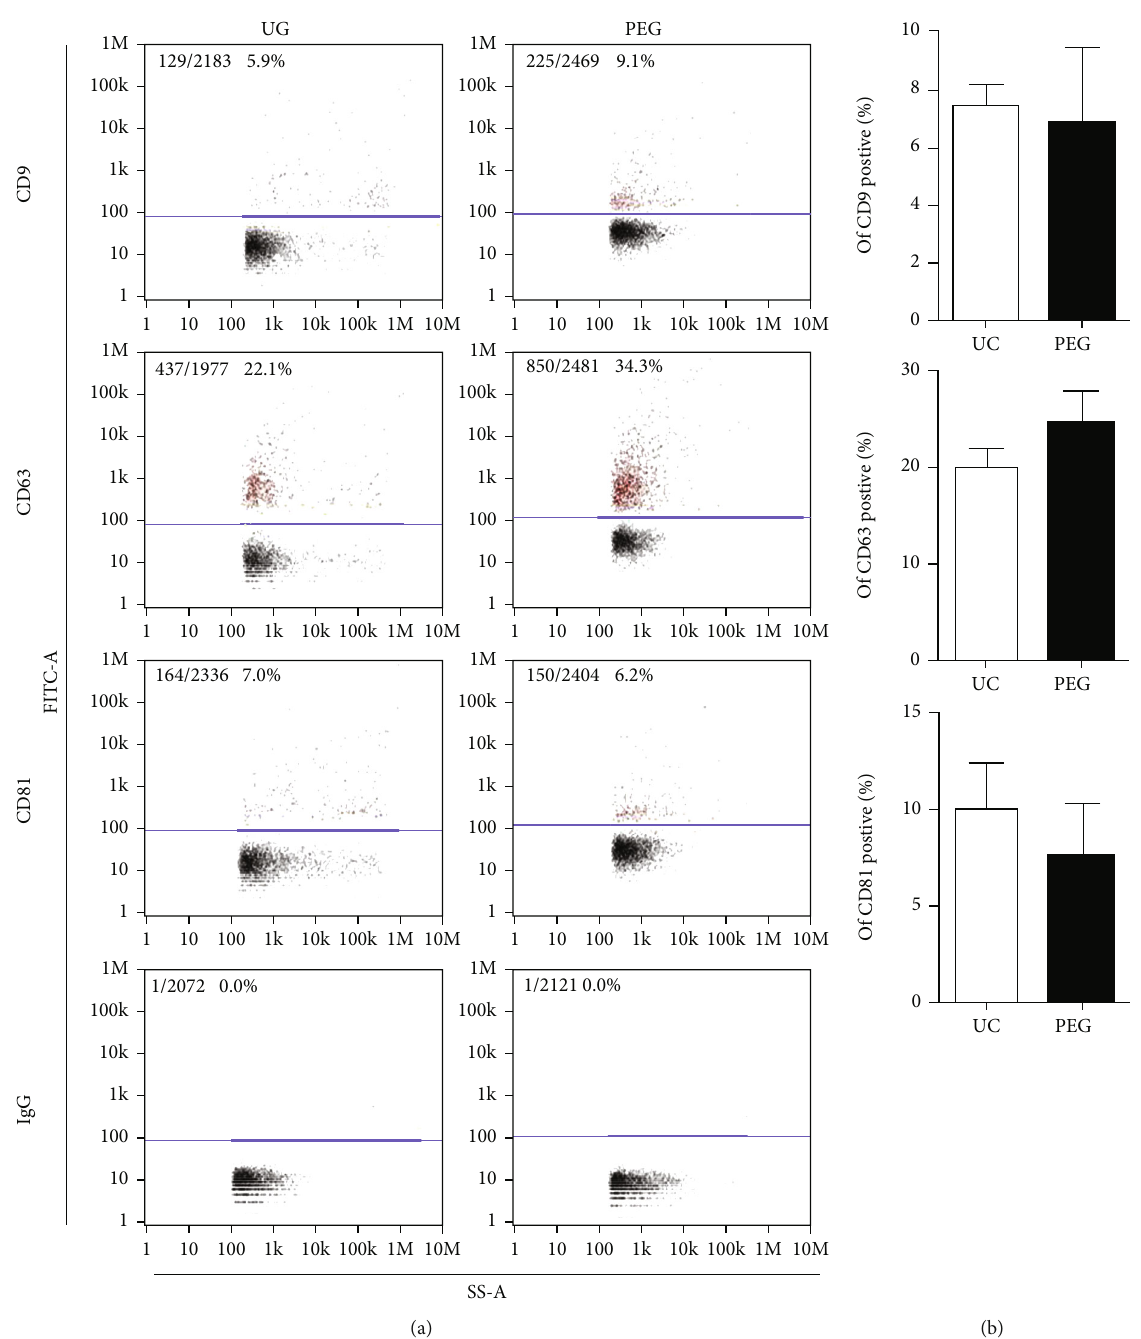
Figure 3: Comparison of the protein expression of UC-EVs and PEG-EVs. (a) The rate of protein expression by nano fl ow cytometry analysis, including CD9, CD63, and CD81. IgG was used as a negative control. (b) Statistical analysis indicated that there were no signi fi cant di ff erences between the UC and PEG groups ( n = 4